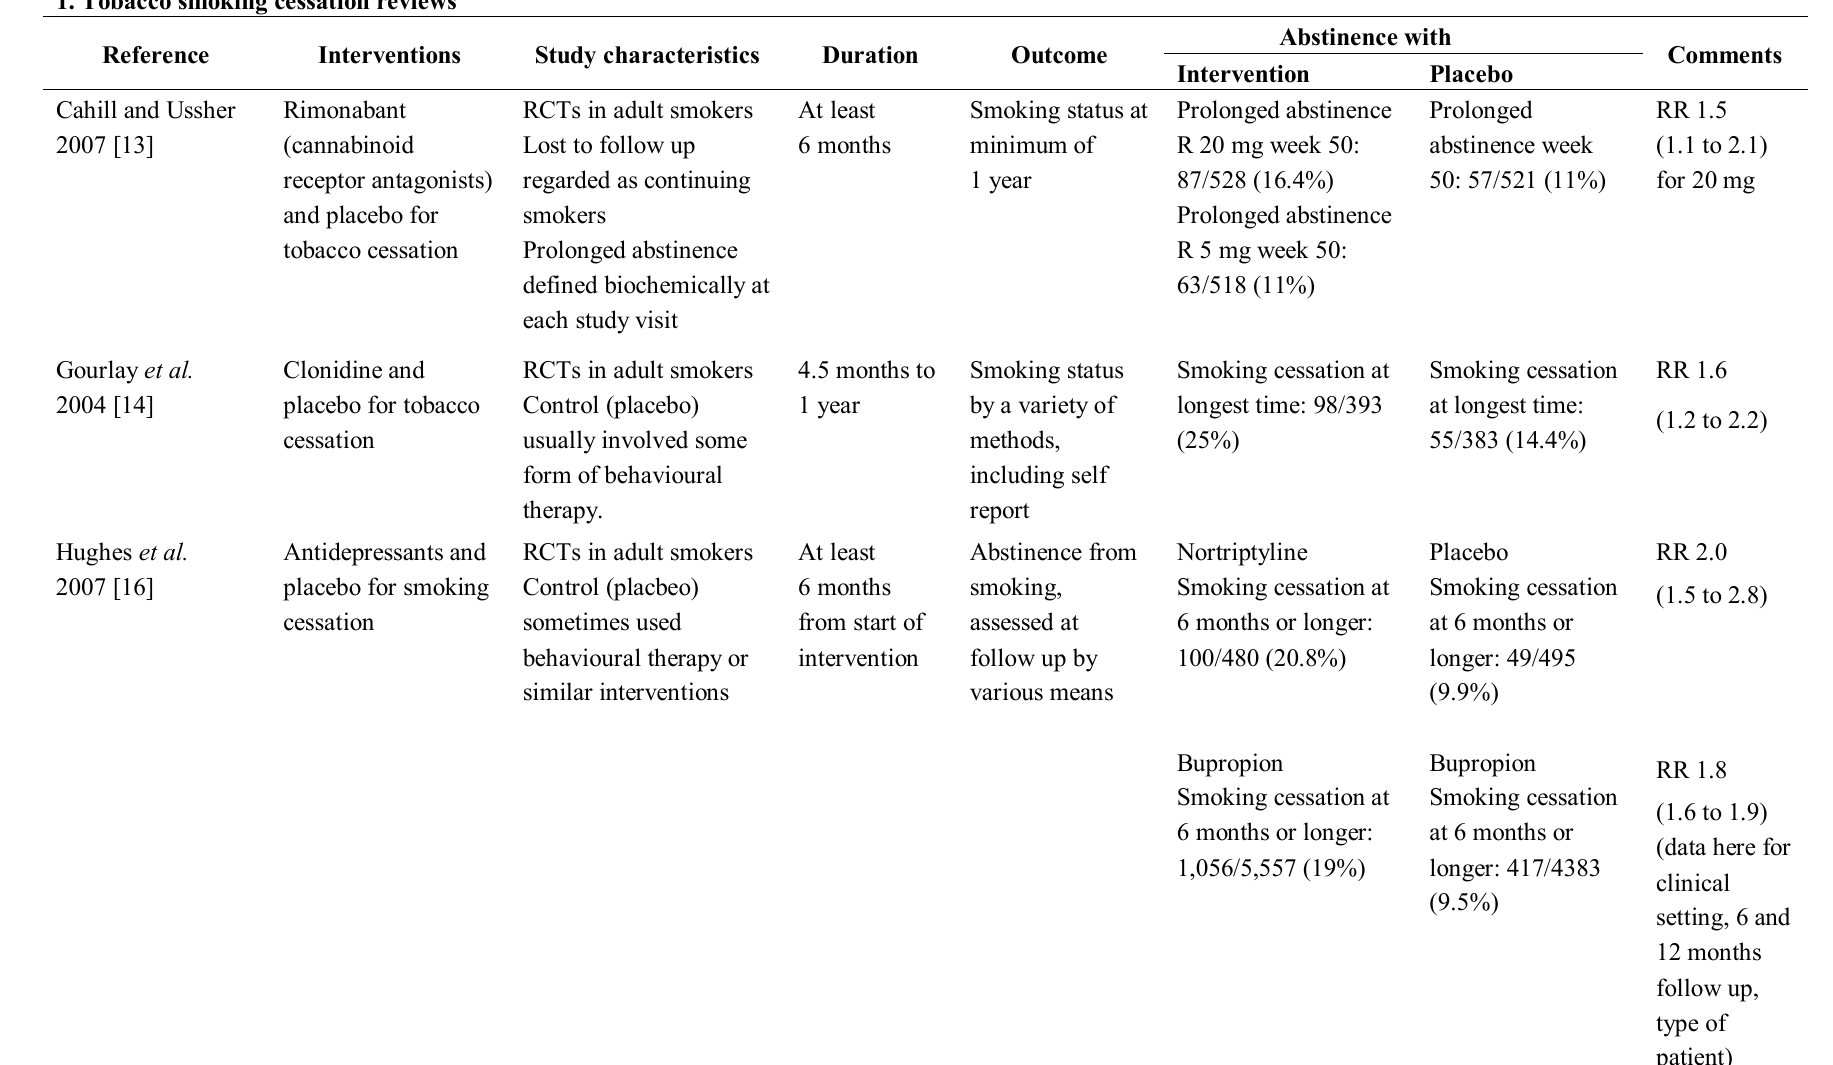
Table 1. Details of included